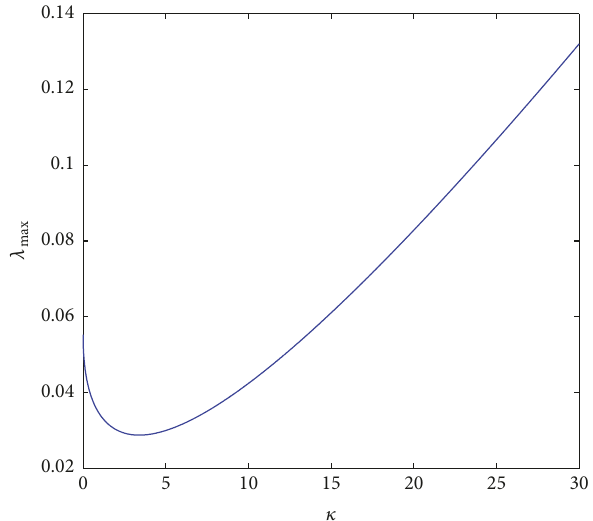
Figure 3: The maximal Lyapunov exponent in zero coupling case in (5a)–(5h). The parameter is fixed as 𝛼 = 0.1 .